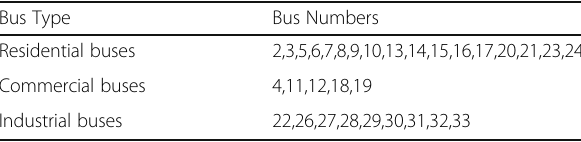
Table 1 Grouping of Buses